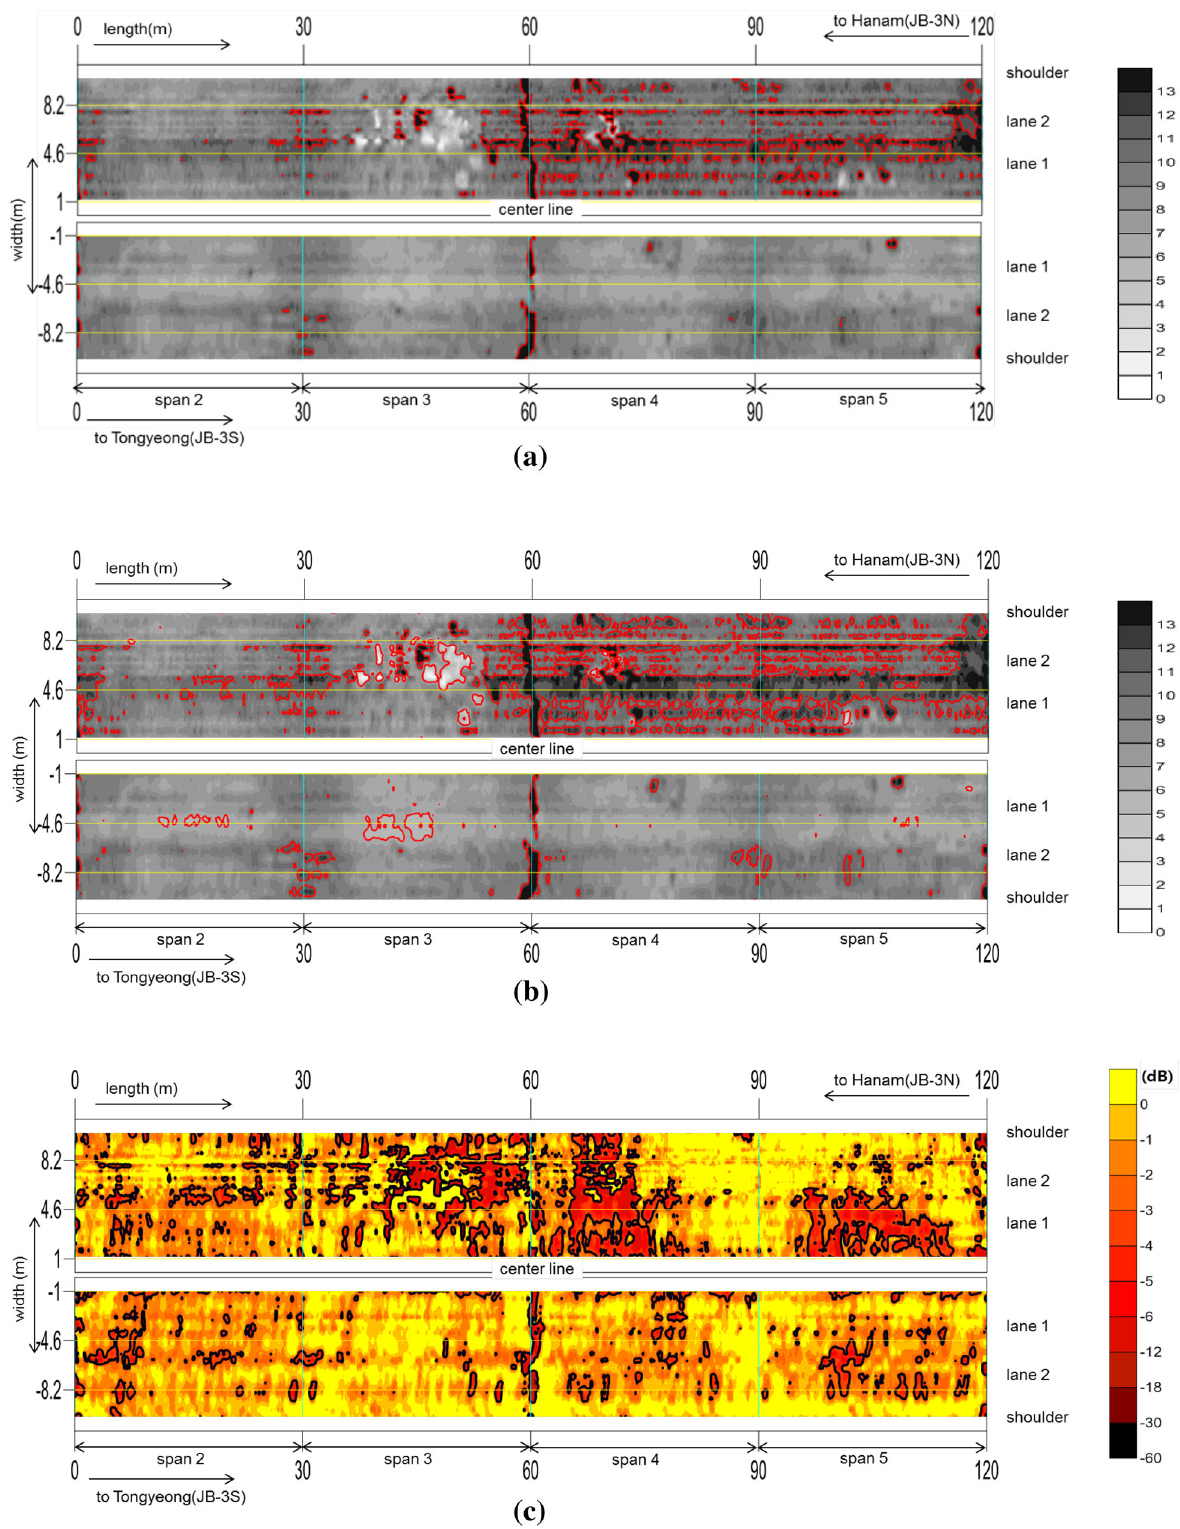
Fig. 14 Condition maps of concrete bridge decks obtained from air-coupled GPR measurements. a cut-off relative permittivity over 12, b cut-off relative permittivity under 6 and over 11, and c depthcorrected attenuation map based on the reflection from the top